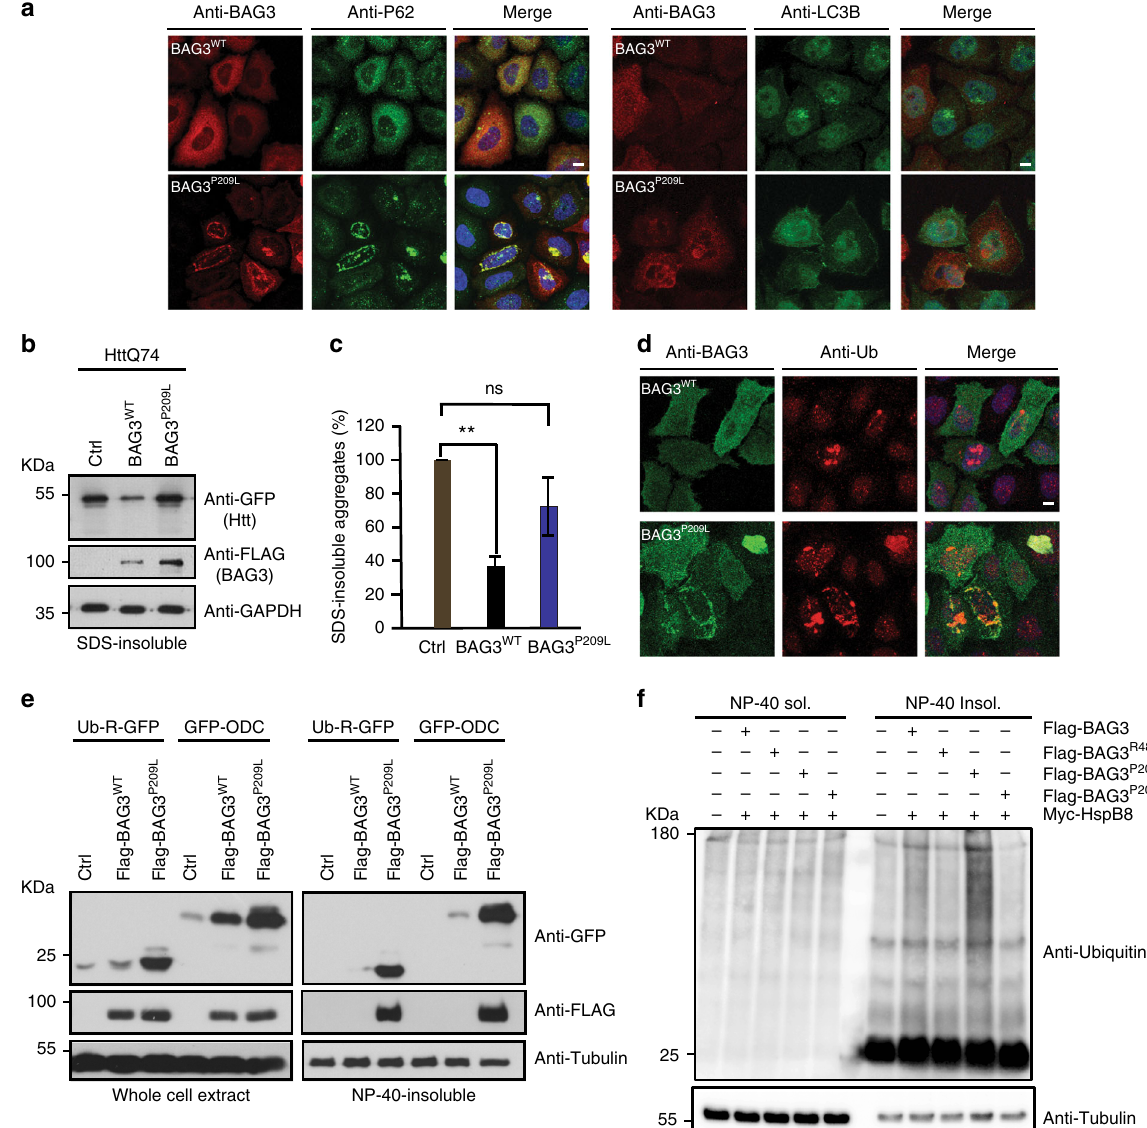
Fig. 6 BAG3 P209L aggregation leads to co-aggregation of proteasomal substrates. a Immuno fl uorescence pictures of HeLa cells expressing FLAG-BAG3 WT or FLAG-BAG3 P209L using antibodies against BAG3 (green) or ubiquitin (red). Scale bar = 5 μ m. b Suppression of GFP-HttQ74 aggregation of cells expressing a control, FLAG-BAG3 WT or FLAG-BAG3 P209L . Western blot against indicated antibodies is shown. c Quanti fi cation of GFP-HttQ74 aggregation of experiments similar to b . Relative percentage of SDS-insoluble protein levels are shown. Data represents the mean and standard deviation of three independent experiments. d Immuno fl uorescence pictures of HeLa cells expressing FLAG-BAG3 WT or FLAG-BAG3 P209L using antibodies against BAG3 (green) or ubiquitin (red). Left column BAG3, middle column ubiquitin and right column is the merge of BAG3 (green), ubiquitin (red), and DAPI (blue). Scale bar = 5 μ m. e Fractionation of HEK293 cells expressing HSPB8, a control or BAG3 WT or BAG3 P209L , together with either Ub-R-GFP or GFP-ODC (ornithine decarboxylase). Western blot against GFP, FLAG (BAG3), Myc (HSPB8), and tubulin are shown. f Fractionation of HEK293 cells expressing HSPB8 and indicated BAG3 variants. Western blot using ubiquitin (FK2) and tubulin antibodies are shown. The same samples as in Fig. 5e have been used, loading control is therefore the same. Source data are provided as a Source data fi